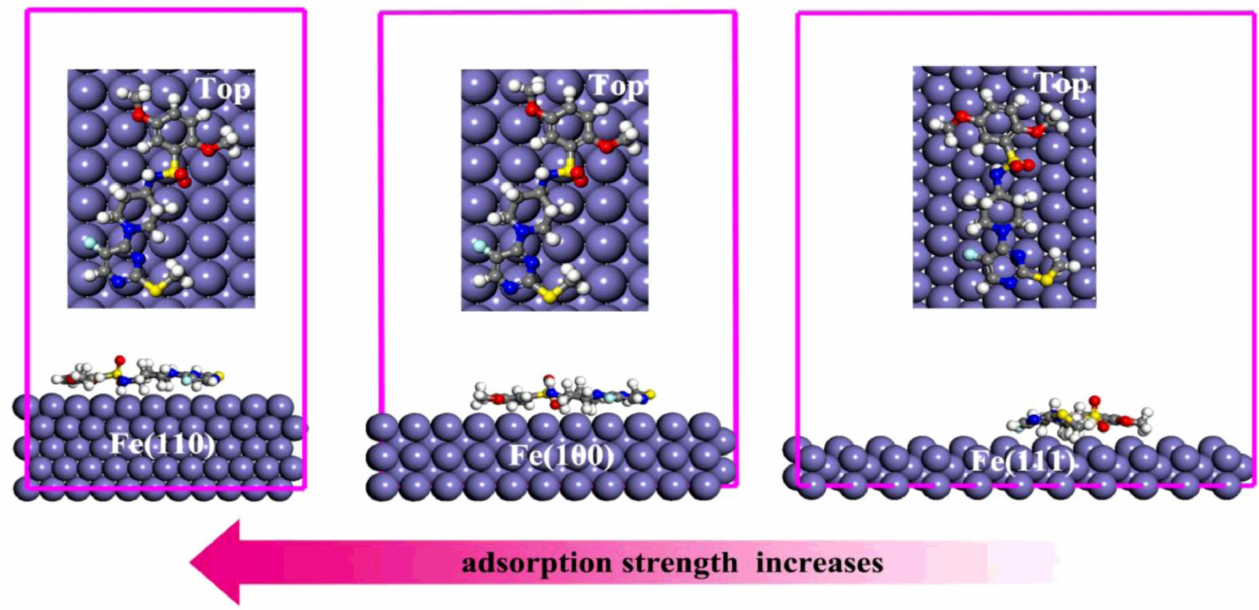
Figure 5. Mode of adsorption of (5-fluoro-2-(methylthio)pyrimidine-4-yl)(piperidine-4-yl)-2,5- dimethoxybenzene sulfonamide (FMPPDBS) on different iron surfaces. (Reprinted with permission from Ref. [127]. Copyright 2016 Elsevier